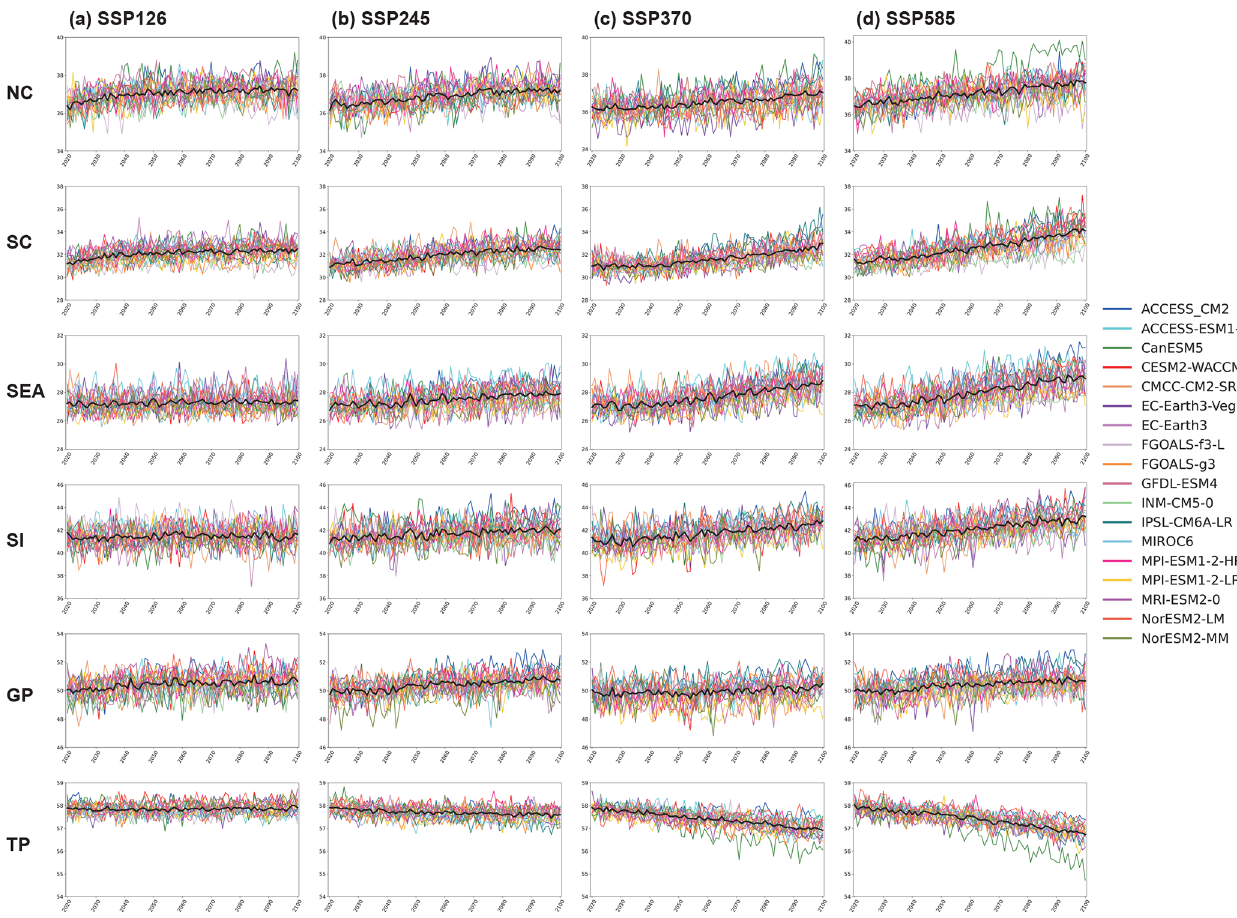
Figure 7. Time series (2020–2100) of annual mean near-surface O 3 concentrations (ppb) driven by climate change under the four scenarios (SSP1-2.6, SSP2-4.5, SSP3-7.0, and SSP5-8.5) over North China (NC; 35–41 ◦ N, 105–120 ◦ E), South China (SC; 22–33.5 ◦ N, 105–120 ◦